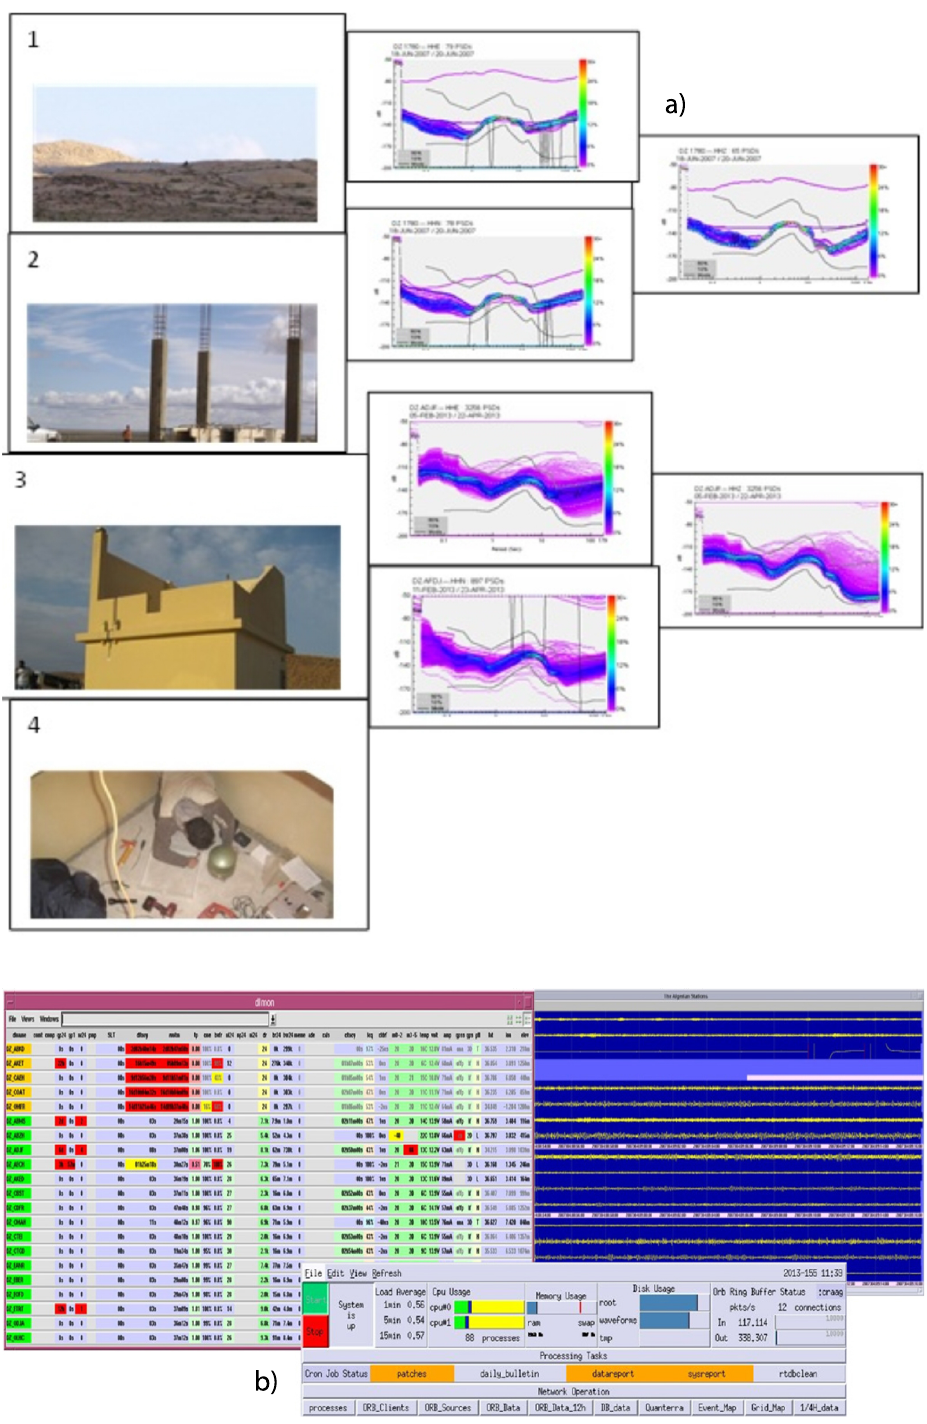
Fig. 3. (a) Data Quality tests using PQLx in different phases of station installation. 1 Site selection 2 Site building 3 Station ended. 4 After several weeks in operation. (b) State of health (dlmon) and rate of